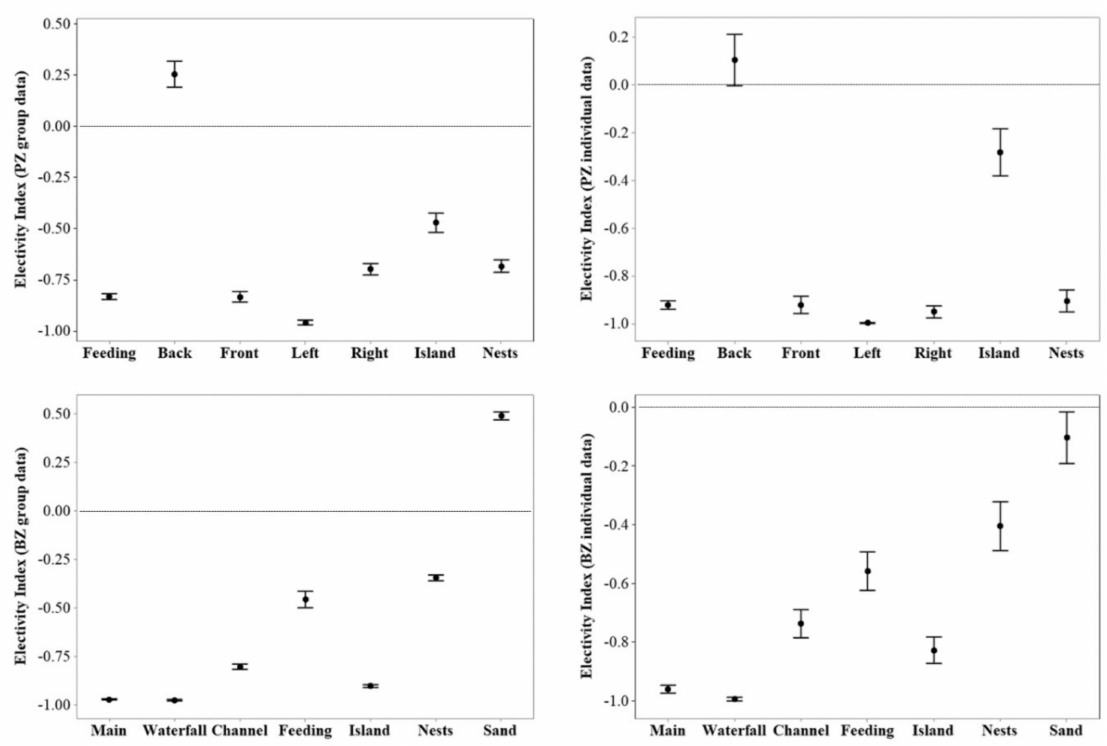
Figure 5. Interval plot of 95% confidence interval of the mean including standard deviation for PZ flamingos ( top ) and BZ flamingos ( bottom ). Values above 0 suggest overuse of an enclosure zone and values below 0 suggest underuse of an enclosure. Values of 0 suggest equal usage of a zone. More variation is noted in individual EI data for each zoo compared to the group EI